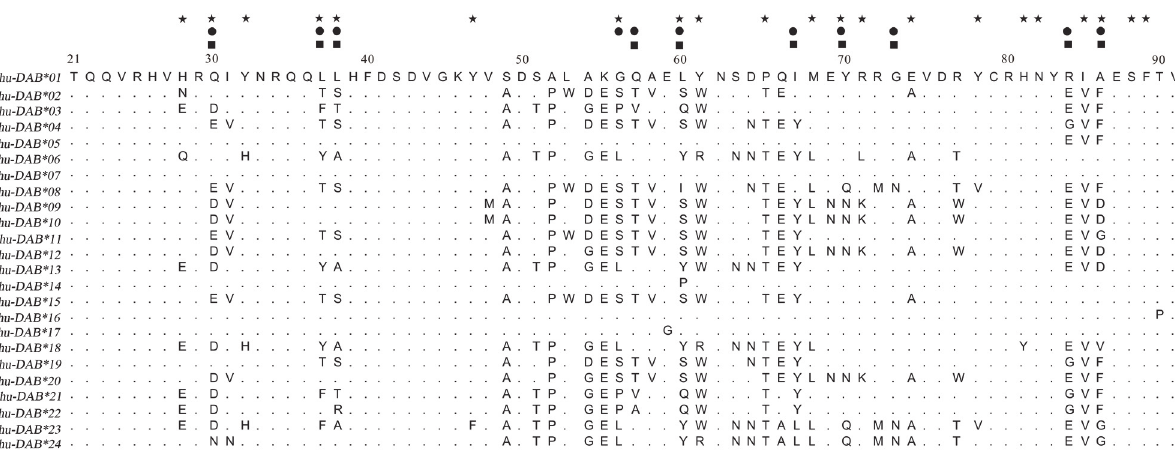
Figure 2. Alignment of the putative amino acid sequences of 24 MHCIIB exon 2 alleles in Syrmaticus humiae . Dots indicate identity with the top sequence ( Syhu-DAB * 01 ). Pentagrams ( $ ) mark the antigen-binding sites (ABS) in the human MHC class II molecule [21]. Black squares ( ■ , model M2a) and circles ( ● , model M8) mark sites under balancing selection based on CODEML